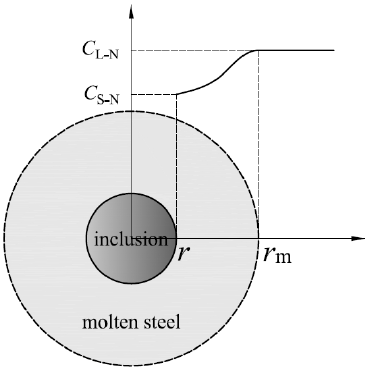
ff usion in molten